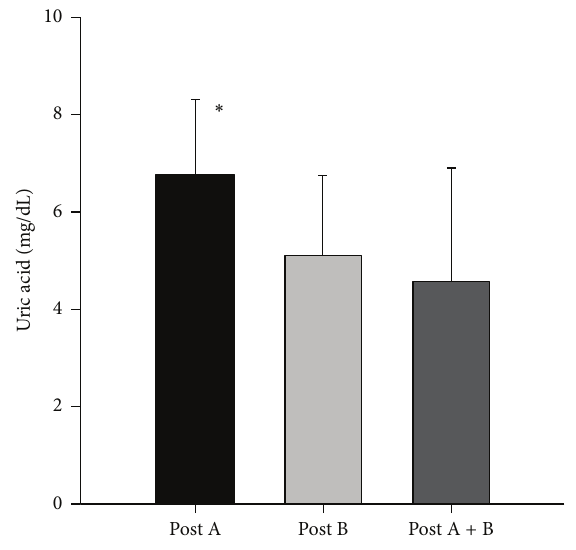
Figure 2: Serum uric acid after treatment with allopurinol (A), benzbromarone (B), or both drugs (A +